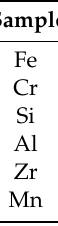
Table 2. The certified impurities in boron powder (ppm mass).